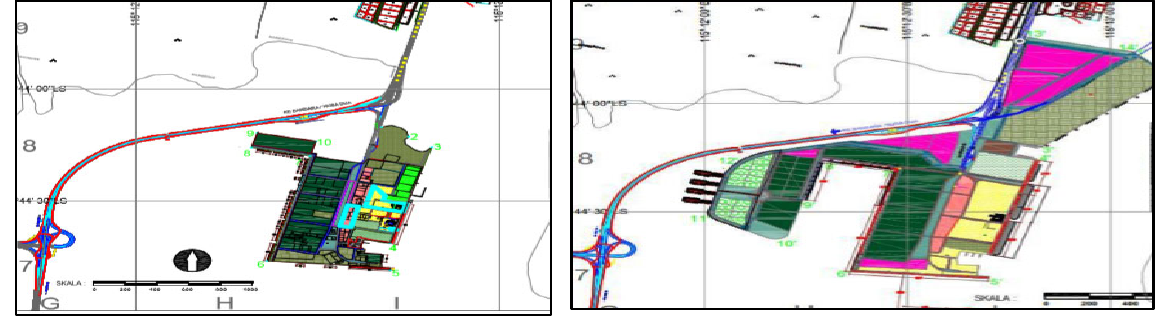
Fig. 2. Existing Condition of Naval Base Harbor Fig. 3. Naval Base Harbor Masterplan